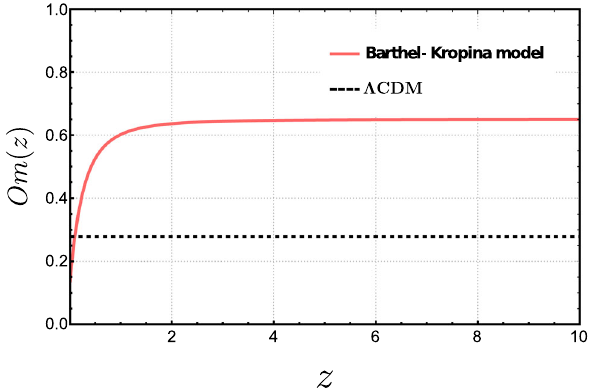
Fig. 16 The evolution of the Om ( z ) function in the Barthel–Kropina and (cid:2) CDM